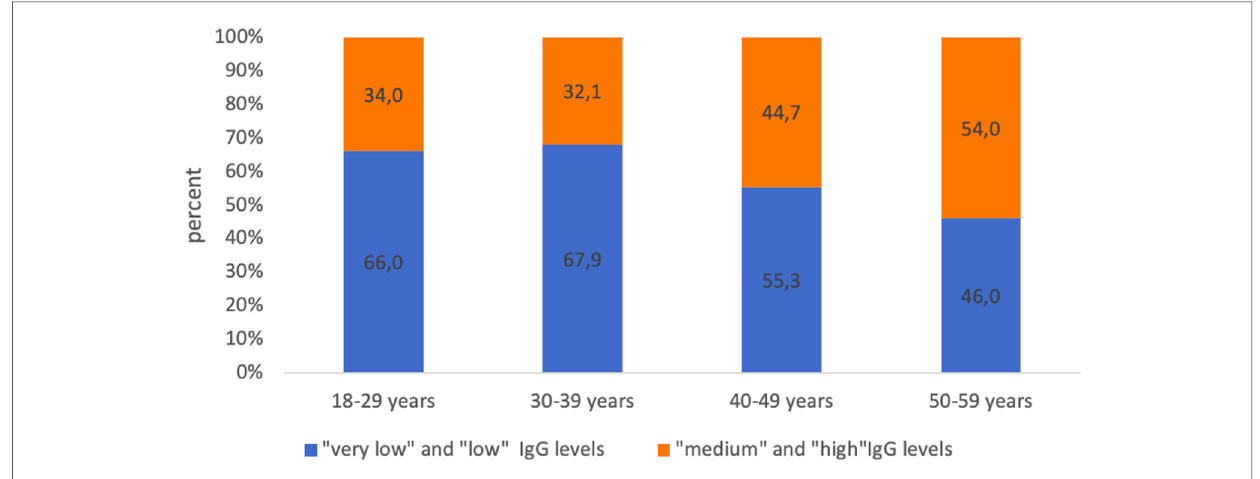
FIGURE 6 Proportion of seropositive healthcare professionals with “ low ” anti-pertussis IgG levels and with “ medium ” and “ high ” anti-pertussis IgG levels in different age groups.